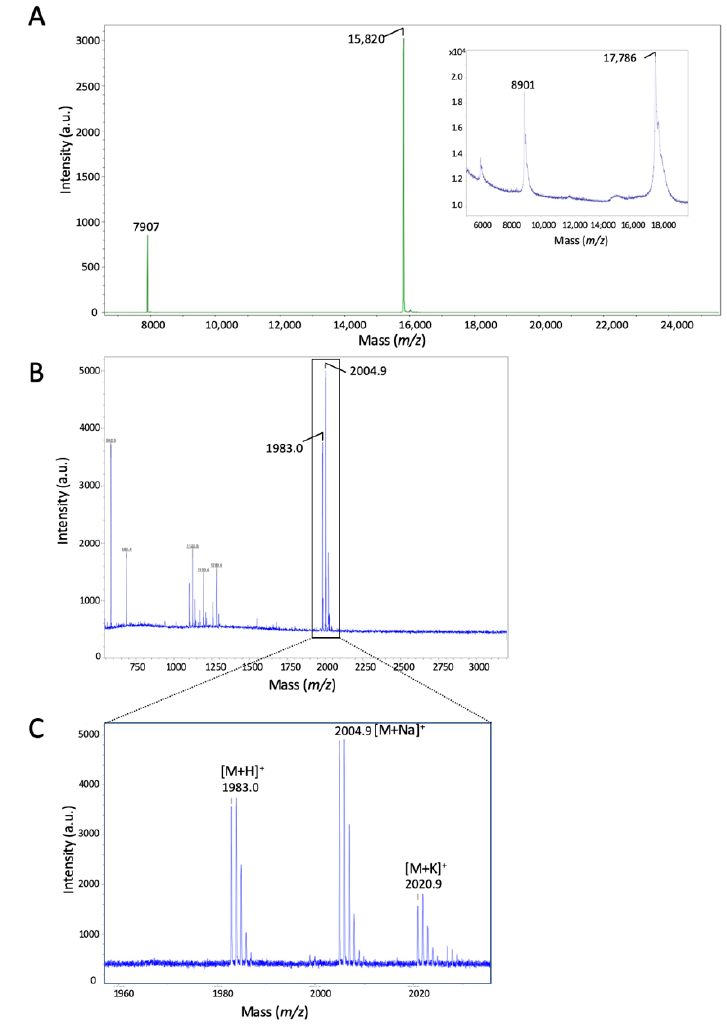
Figure 4. Identification of the calpain-2 cleavage site using MALDI-TOF mass spectrometry. ( A ) MALDI-TOF spectra showing Reg-1 α treated with calpain-2 in the linear mode ( m / z values from 7000 to 25,000). Inset, profile of the uncleaved protein and ( B ) the cleaved fragment in the reflectron mode ( m / z 600–3000). ( C ) Enlargement of the spectrum of ( B ) obtained in the region of m / z 1960–2030. Note the presence of both sodium [M + Na] + and potassium [M + K] + adducts. The molecular weights, in Da, are shown above the peaks of each major entity.